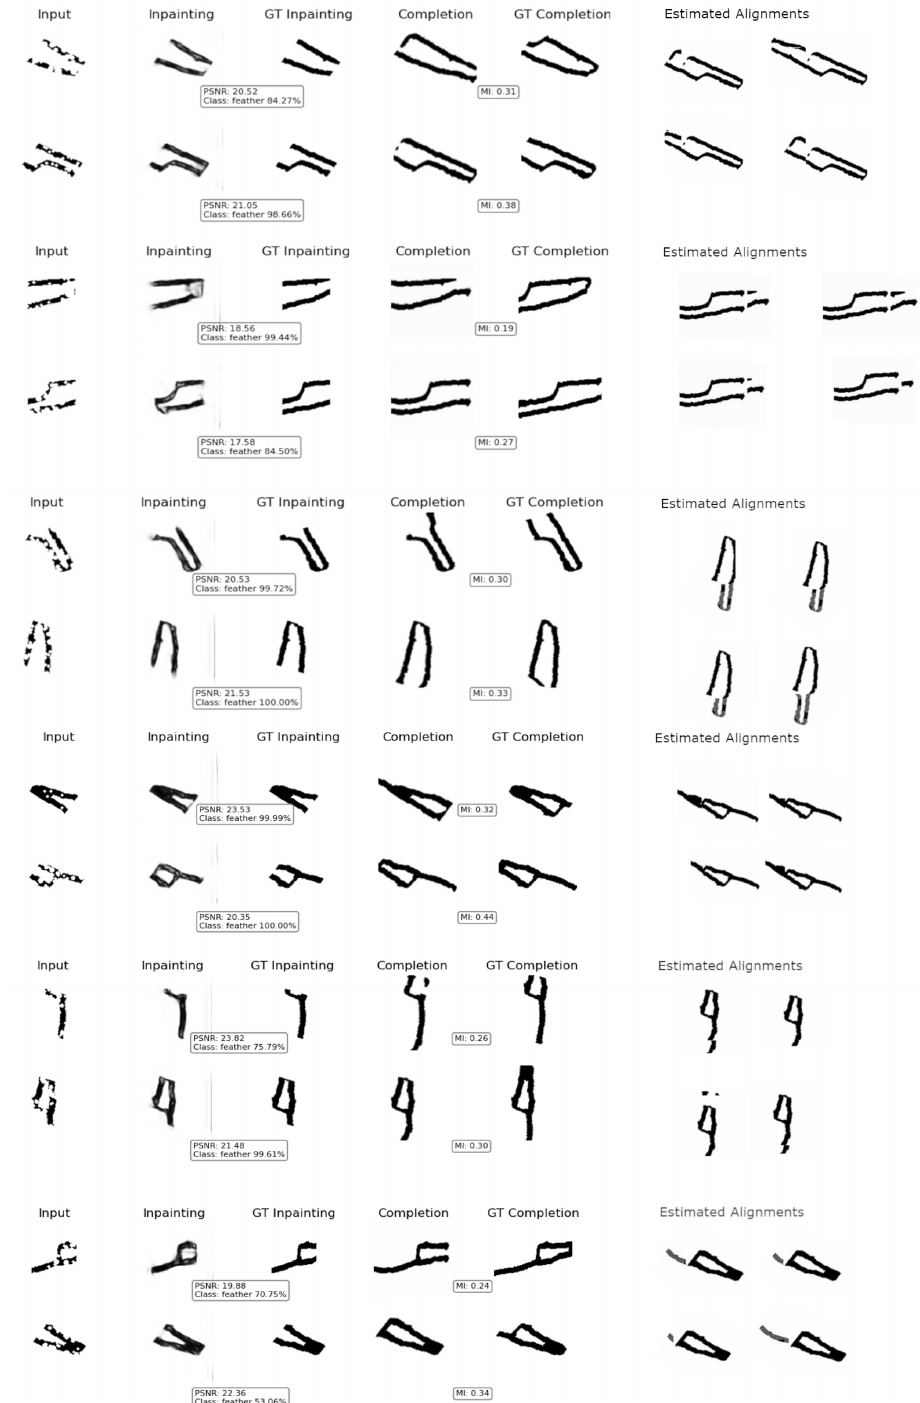
Figure 17. Examples of obtained results for the feather sign. From inpainting to